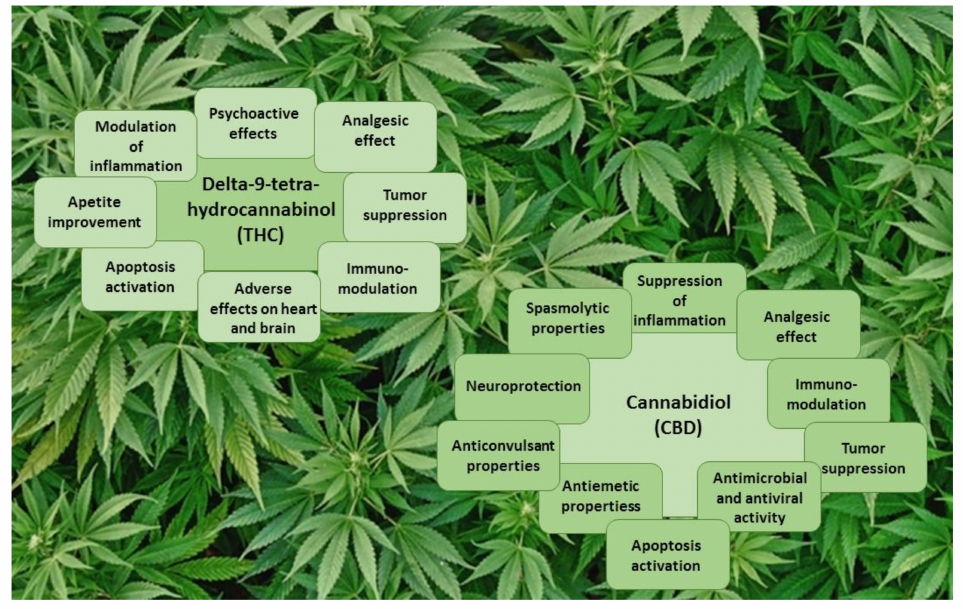
Figure 3. The main effects of THC and